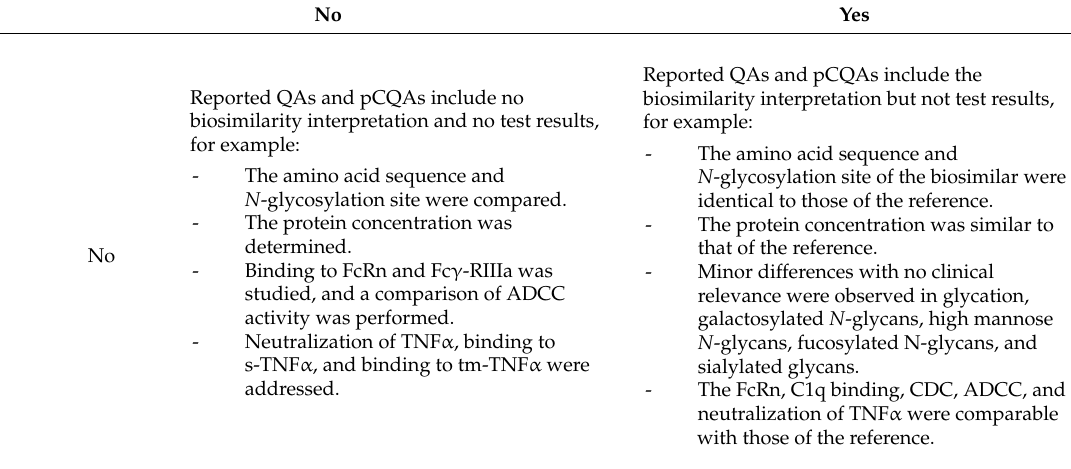
Table 3. Definitions of the four reporting categories for the quality attributes (QAs) and potentially critical quality attributes (pCQAs) reported in biosimilarity assessments in the initial European public assessment reports (EPARs) [47]. Reporting